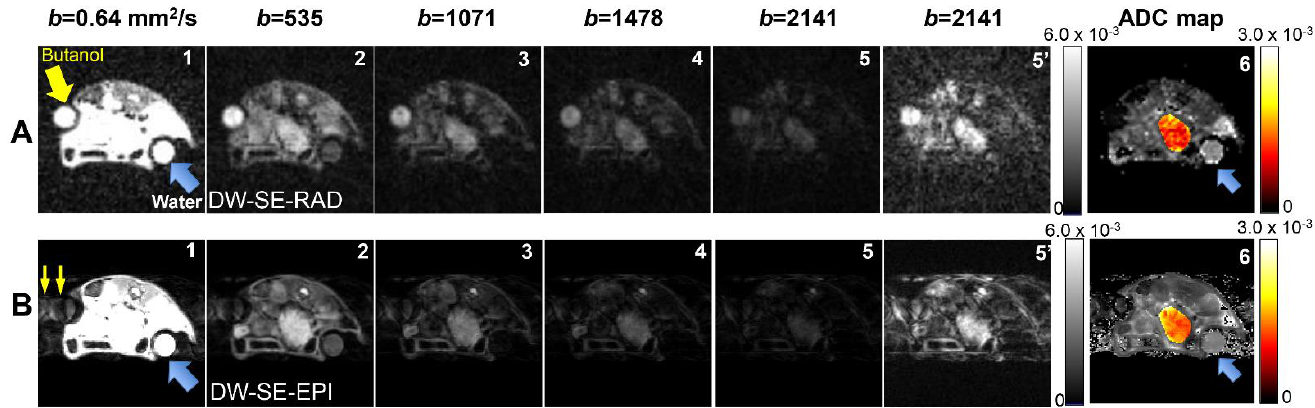
Figure 2. Representative diffusion-weighted images and ADC maps obtained from the two diffusion-weighted MRI (DWI) protocols. Rows A and B are diffusion-weighted images at similar slice positions generated by the DW-SE-RAD and diffusion-weighted spin-echo 4-shot echo-planar imaging (DW-SE-EPI) protocol, respectively. For each row, the first five images ( 1–5 ) are windowed to highlight the decay due to diffusion weighting, while frames ( A5’ , B5’ ) are windowed to optimally display ( A5,B5 ), respectively. ( A6 , B6 ) are ADC maps (mm 2 /sec) displayed in color overlay for the tumor and in grayscale for other tissues and phantoms. Blue arrows point to the water phantom, while yellow arrows to the 1-butanol phantom. Due to its low diffusion coefficient (~0.44 × 10 −3 mm 2 /sec), 1-butanol appears dark in the gray-scaled ADC map ( A6 ) produced from the DW-SE-RAD protocol.